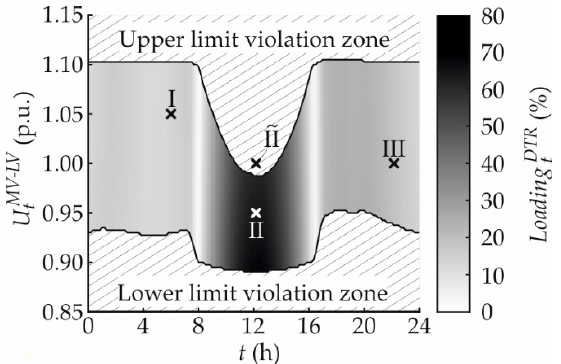
Figure 15. Daily distribution transformer loading within the rural LV_Link-Grid for various MV − LV boundary voltages and no Volt/var control.